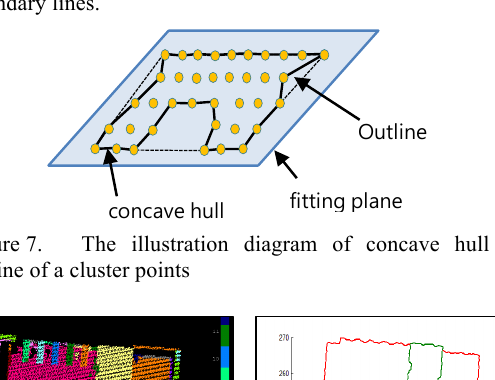
Figure 5. Split-and-merge segmentation for point group of the gable roof. (a)-(d) Splitting process; (e) results of merging process; (f) tree representation (using a quadtree for simplicity).